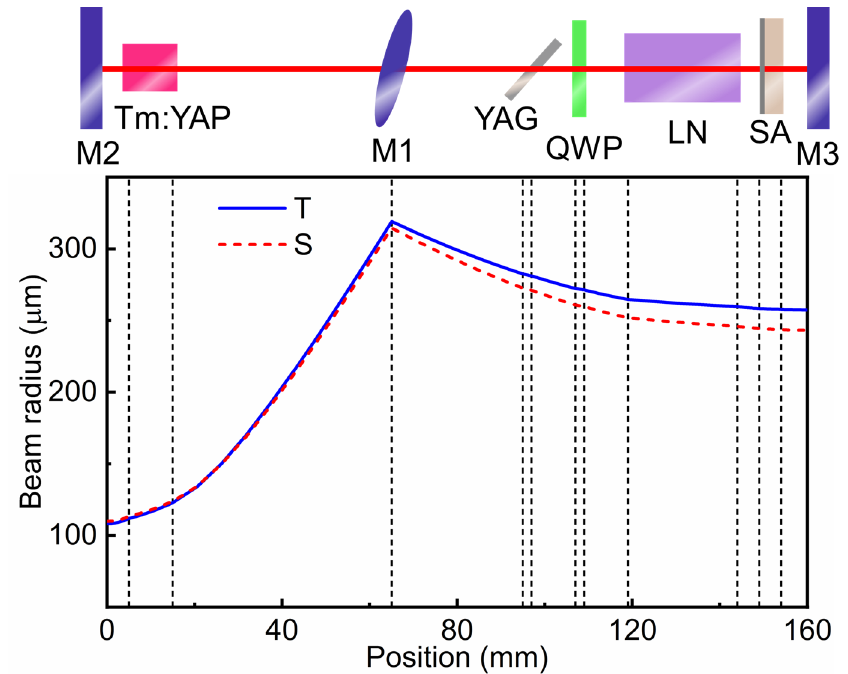
Figure 9. Laser beam radius distribution along the propagation direction.